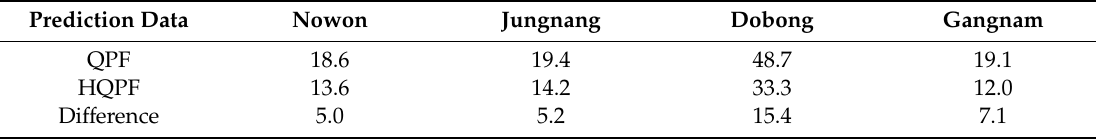
Table 6. MAE (mm / 3 h) calculated at four sites from QPF-based rainfall and HQPF-based rainfall with respect to a heavy rainfall event in Seoul (section